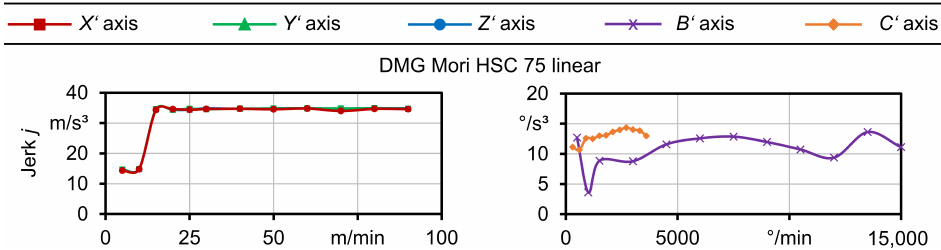
Figure 4. Mean jerk values measured while accelerating from standstill in dependence of the target feed rate for the machining centre DMG Mori HSC 75 linear. Table 1. Maximum jerk values measured for the axis drives.